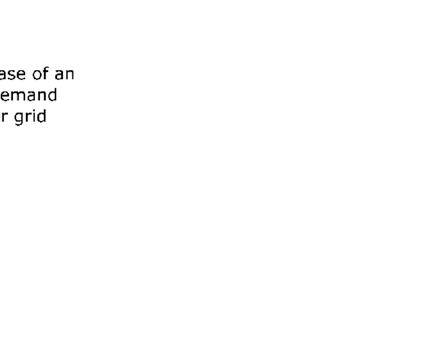
Figure 1. Connection of a HP and a CHP operating in a DHN to the public power grid. ▬ = Low temperature heat; ▬ = High temperature heat; ▬ = Electricity.